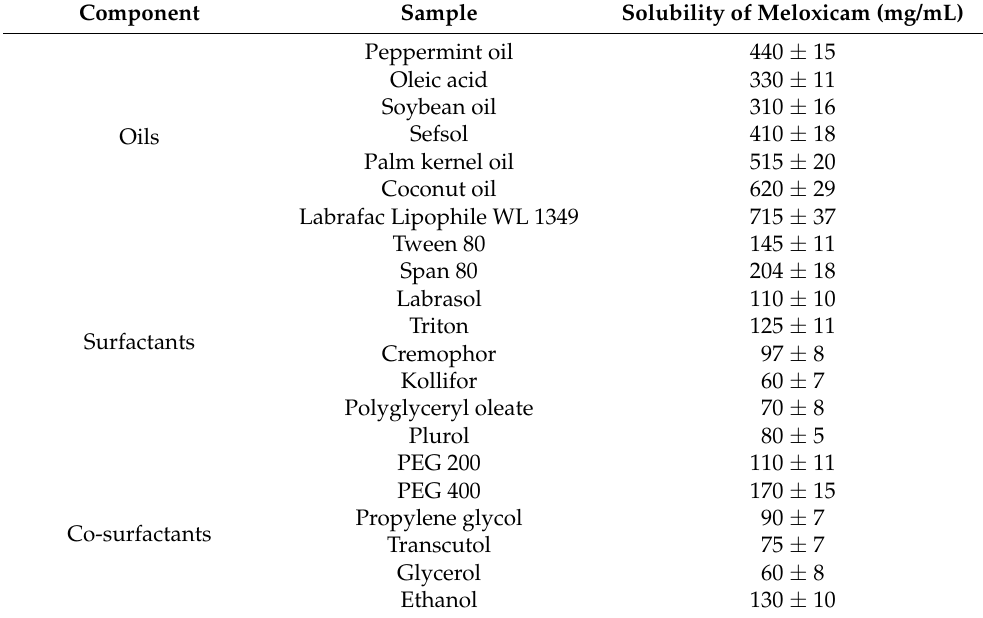
Table 3. Solubility data of Meloxicam (MX) in various oils, surfactants, and co-surfactants.